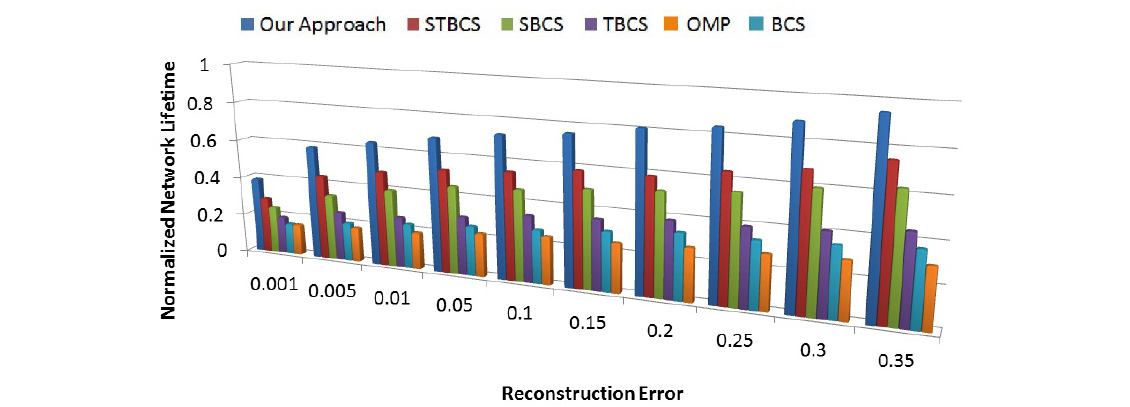
Figure 16. Normalized network lifetime versus reconstruction error